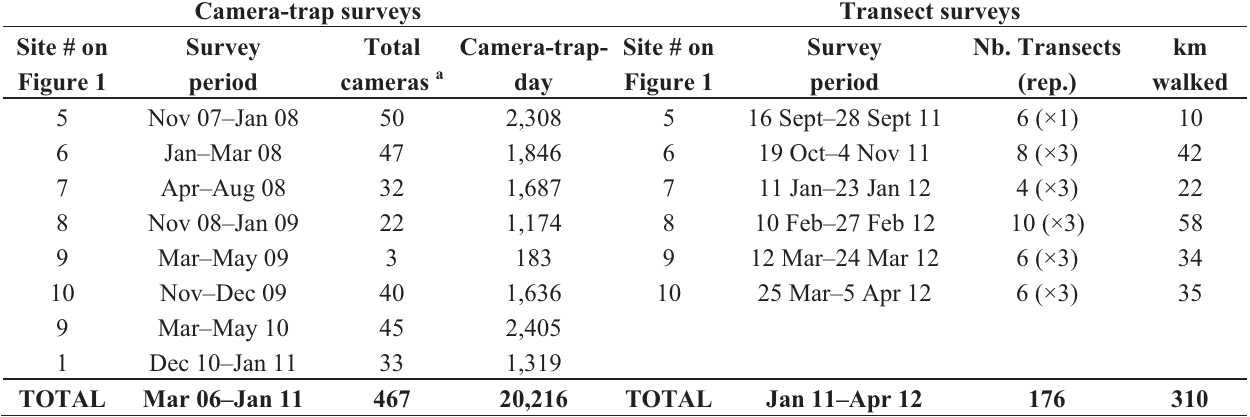
Total Camera-trap- Site # on cameras a day Figure 1